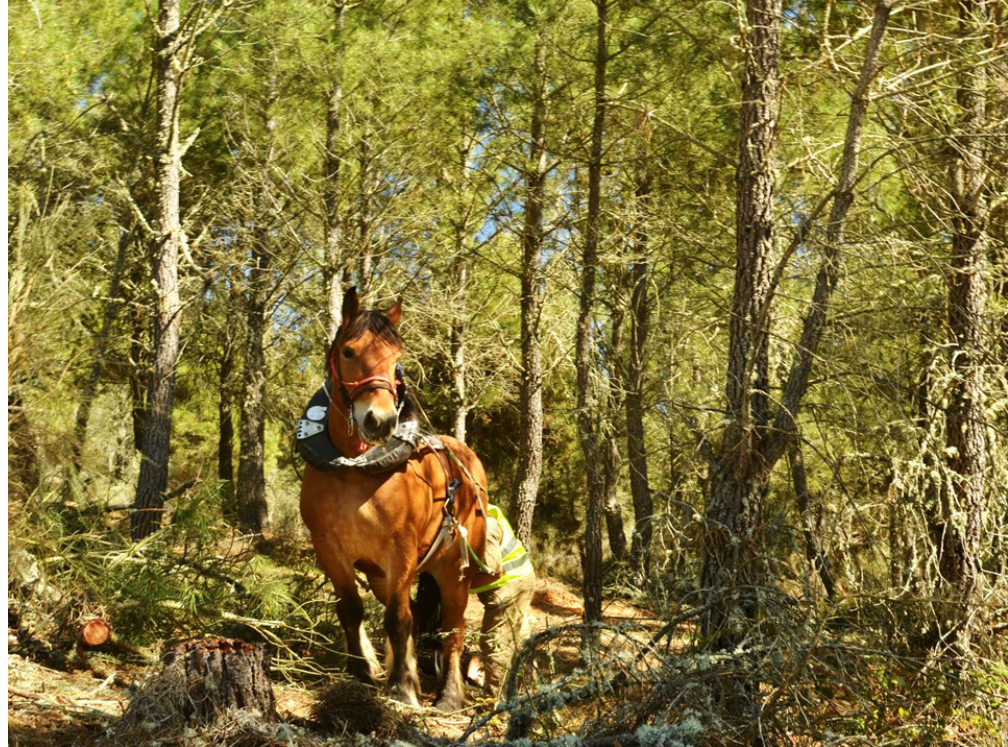
Figure 4: Logging operations using horses, during intermediate cuttings of immature pine trees in a forest managed by the Municipality of Vimioso, Northeast of Portugal. Animal traction has gradually been recognized as a very interesting tool for sustainable management of